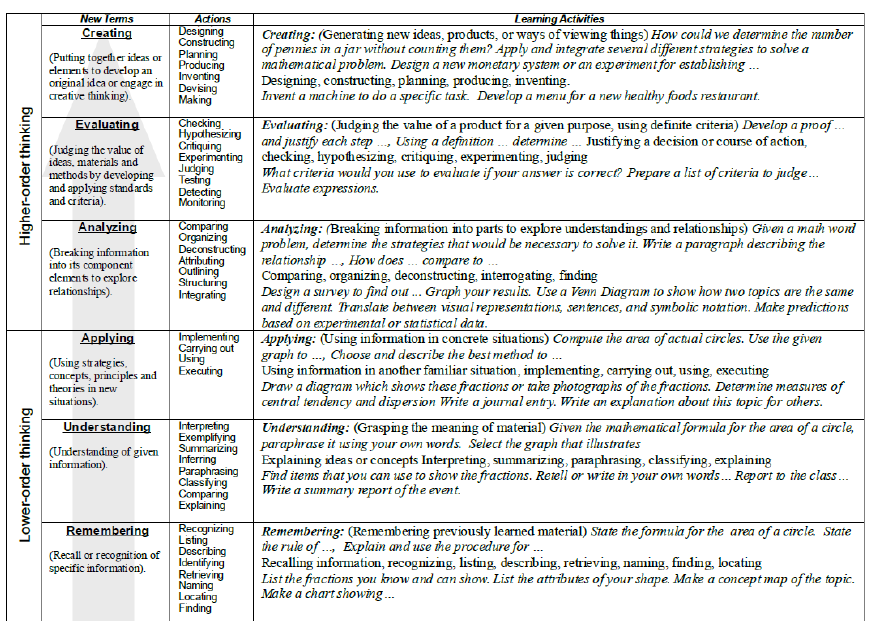
Table 1. A list of measurable verbs used in